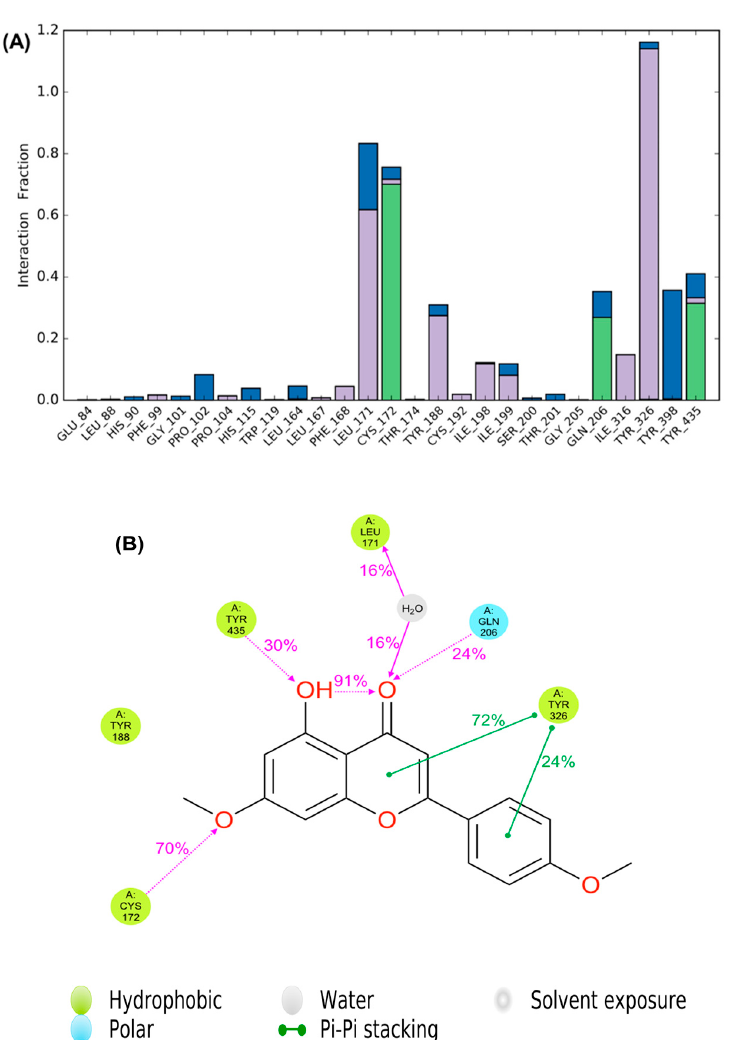
Figure 9. SID (Simulation Interactions Diagram) plots showing the protein-ligand interactions between the amino acid residues of the h MAO-B binding site and acacetin 7-methyl ether during the MD simulation. ( A ) The stacked bar charts are categorized as follows: hydrogen bonding (green), hydrophobic interactions (violet), and water bridges (blue) formed. ( B ) A schematic of detailed ligand atom interactions with the protein residues.